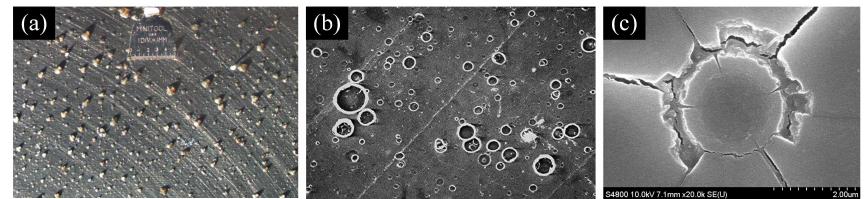
Figure 23. Captured droplets depositing the surface after after plume–surface interactions on the ( a ) ground test [7] and ( b ) on-orbit test [11]. ( c ) The surface damage observed in on-orbit test